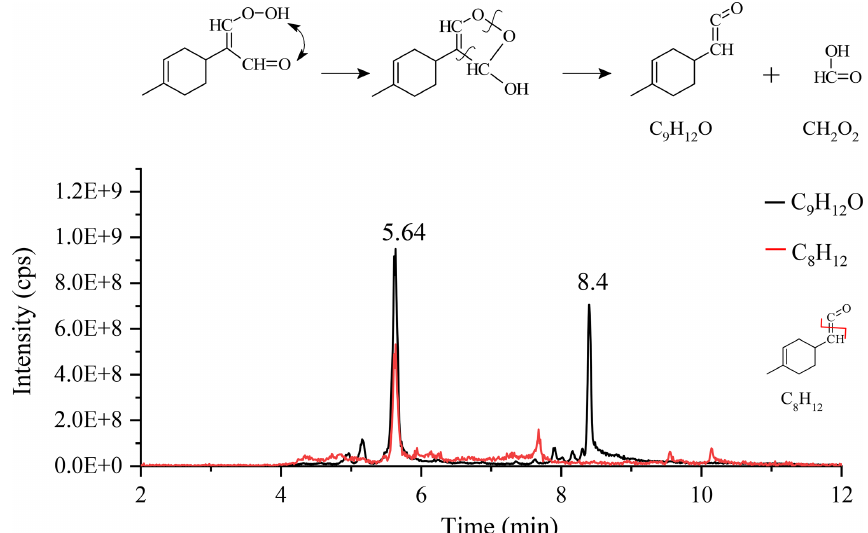
Figure 5. Korcek mechanism for the #4 KHP isomer and chromatograms of C 9 H 12 O and the fragment C 8 H 12 (APCI( + ), vaporizer tem- perature = 120 ◦ C, sheath gas flow of 50a.u., auxiliary gas flow of 0a.u.; sweep gas flow of 0a.u., capillary temperature of 300 ◦ C, corona current of 3µA).